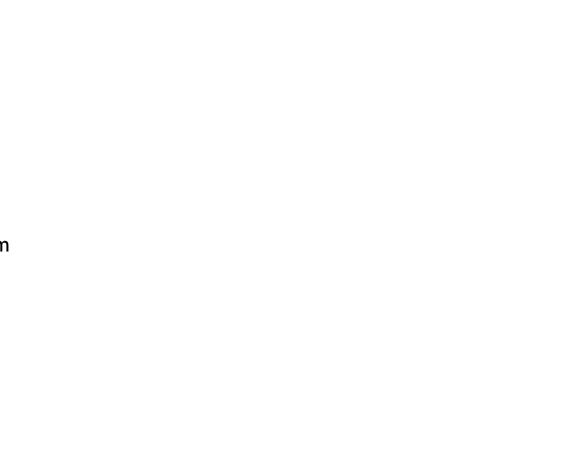
Figure 5. Acoustic measurement setup for generating a local sound field with 180 ◦ optical access.